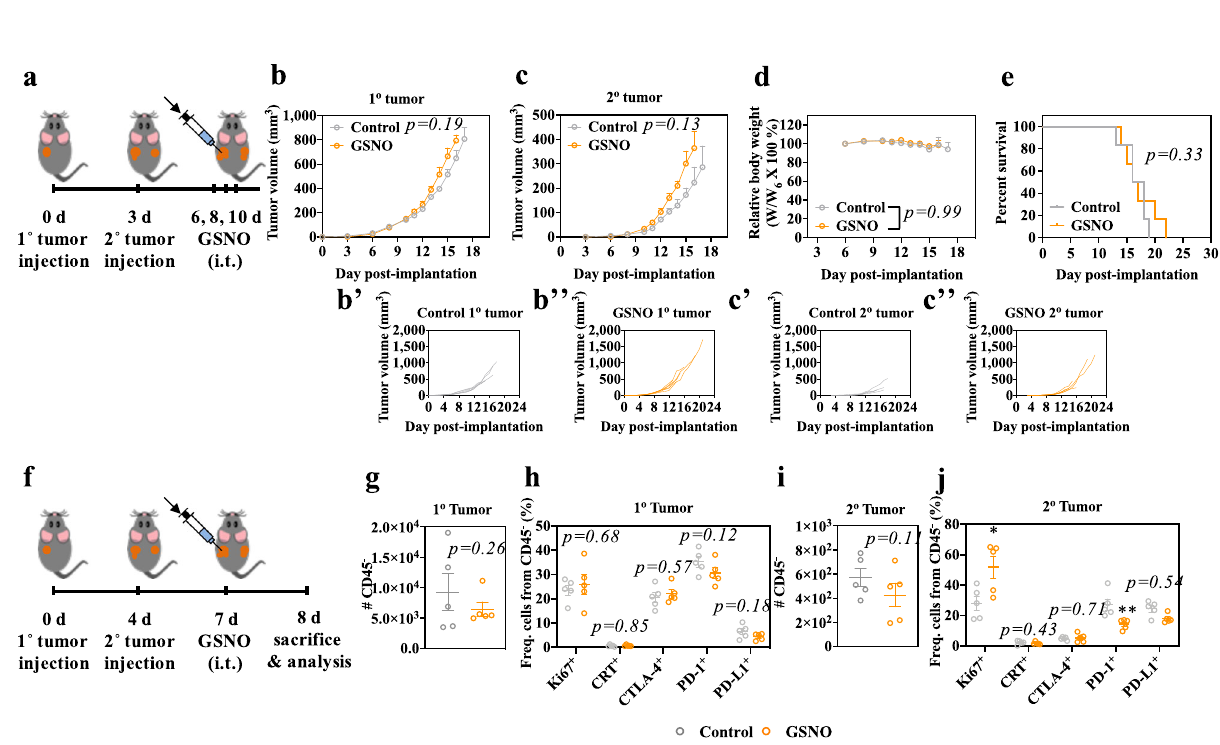
Fig. 2 Intratumorally administered GSNO effects on tumor growth. a Tumor model and treatment schedule. 1 o and 2 o tumors were formed in C57Bl/6 mice by inoculation of 10 5 B16F10-OVA cells in 30 μ L saline on day 0 and day 3, respectively. GSNO (570 μ g kg − 1 ) in 30 μ L saline was administered on day 6, 8, and 10. b , c Average and (B', B'', C', C'') individual volumes of ( b ) 1 o (directly injected) and ( c ) 2 o tumors (uninjected). d Relative body weight changes post treatment. e Kaplan – Meier survival curves. f Tumor model and treatment schedule. 1 o and 2 o tumors were formed by inoculation of 10 5 B16F10-OVA cells in 30 μ L saline on day 0 and day 4, respectively. GSNO (570 μ g kg − 1 ) was administered i.t. on day 7. Gating strategy can be found in Supplementary Fig. 22. g – j Number or frequency of each population of the indicated parent gate in the ( g , h ) 1 o or ( i , j ) 2 o tumor. g , i CD45 − ; h , j Ki-67 + ( j p = 0.0677), CRT + , CTLA-4 + , PD-1 + ( j p = 0.0144), and PD-L1 + of CD45 − . Data are presented as individual biological replicates and mean ± SEM. b – e n = 6. g – j n = 5. *****p < 0.0001, ****p < 0.001, ***p < 0.01, **p < 0.05, and *p < 0.1. b, c ANOVA using linear mixed-effects model. d Two-way ANOVA using Tukey post- hoc statistical hypothesis. e Log-rank using Mantel – Cox statistical hypothesis. g – j Two-tailed Student t -test. Source data are available in a Source Data fi